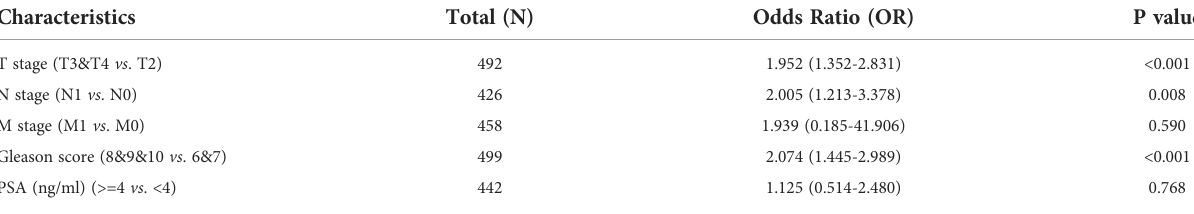
TABLE 2 MAFG-AS1 expression associated with clinical pathological characteristics (logistic regression). Characteristics Total (N) Odds Ratio